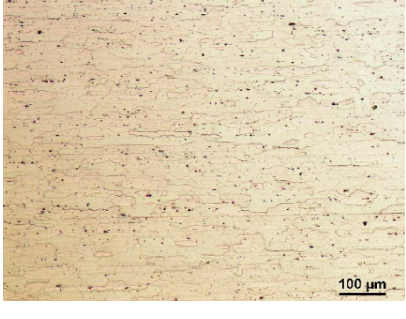
Figure 9. DSC curves for EN AW-7075 at a heating rate of 10 K/min. ( a ) After SHT and aging for 3 h and 24 h, ( b ) after retrogression at various temperatures and aging for 24